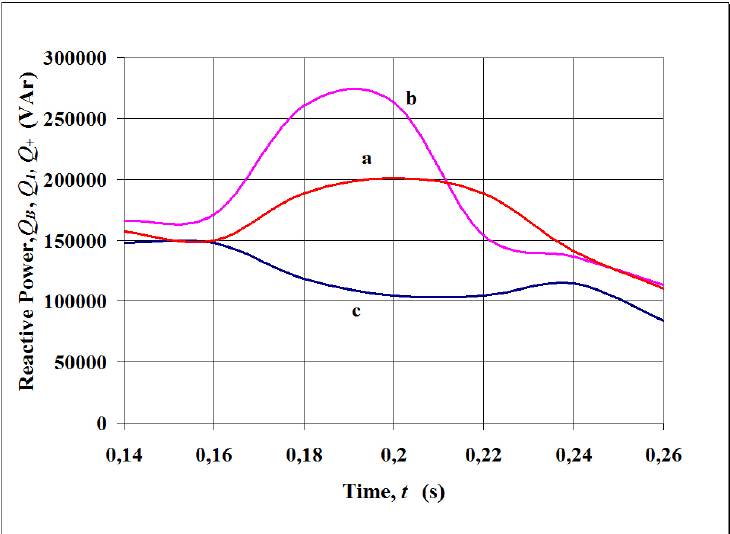
Figure 7. Reactive powers: ( a ) Delayed Voltage, ( b ) Czarnecki, ( c )